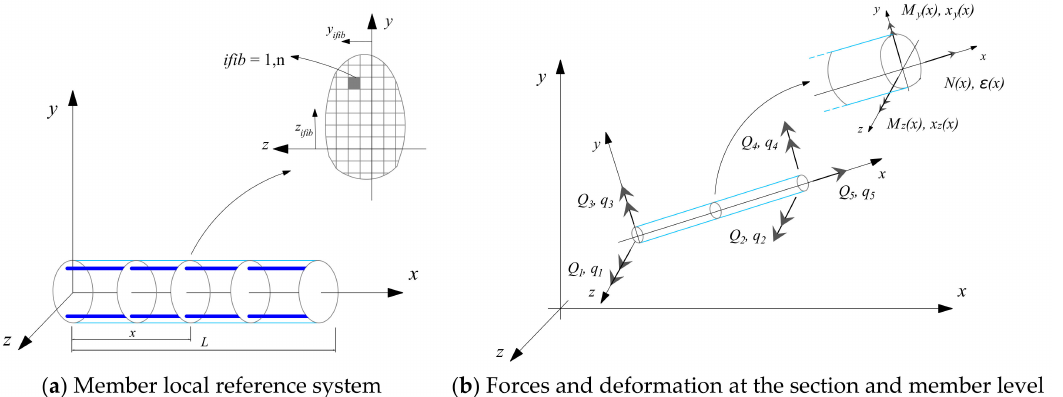
Figure 7. Beam element in the local reference system: subdivision of cross-section into